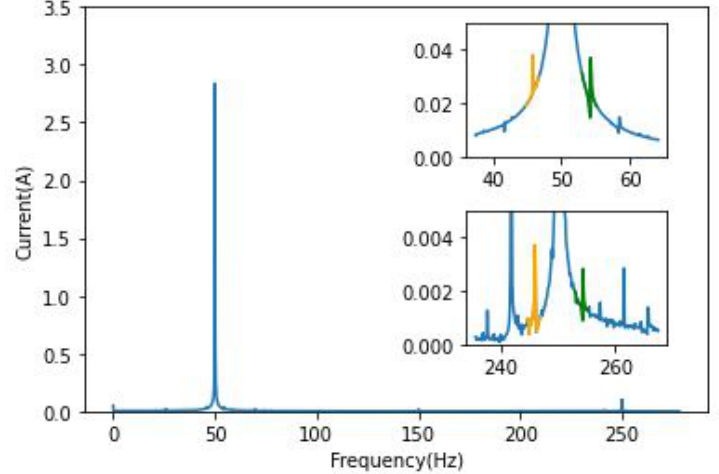
Figure 3. FFT phase current of 1BRB IM/Zoom around 50 and 250 Hz.